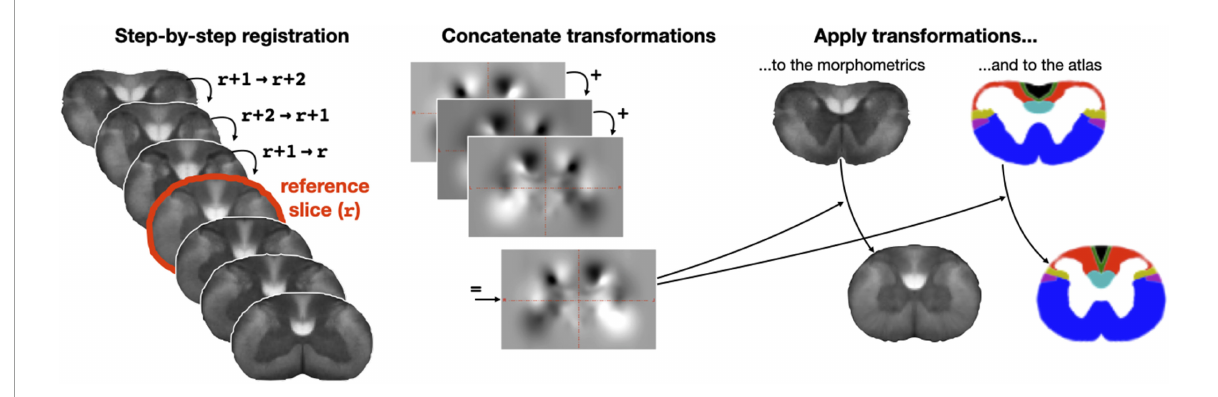
FIGURE3 Step-by-step slice-wise registration. Slices from the morphometric template are non-linearly registered to their adjacent slice until reaching a reference slice, which is defined as the mid-slice within a region (here the cervical region is shown). Then, transformations are concatenated in a step-by-step fashion and the transformation corresponding to a given slice is applied to each morphometric map and to the Watson atlas. This procedure is repeated for each region (cervical, thoracic, lumbar,